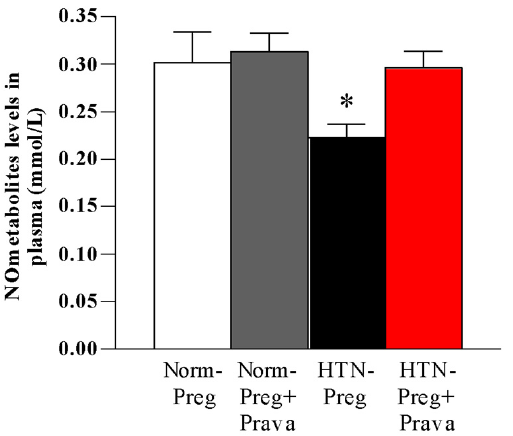
Figure 4. Plasma levels of NO metabolites determined in Norm-Preg, Norm-Preg + Prava, HTN-Preg, and HTN-Preg + Prava groups. Values represent mean ± SEM. * p < 0.05 vs. Norm-Preg group. Lipid peroxide levels in plasma were significantly increased in the HTN-Preg group compared to the Norm-Preg, Norm-Preg + Prava, and HTN-Preg + Prava groups (Figure 5 and Supplementary Table S1), demonstrating that pravastatin inhibited oxidative stress induced by hypertensive